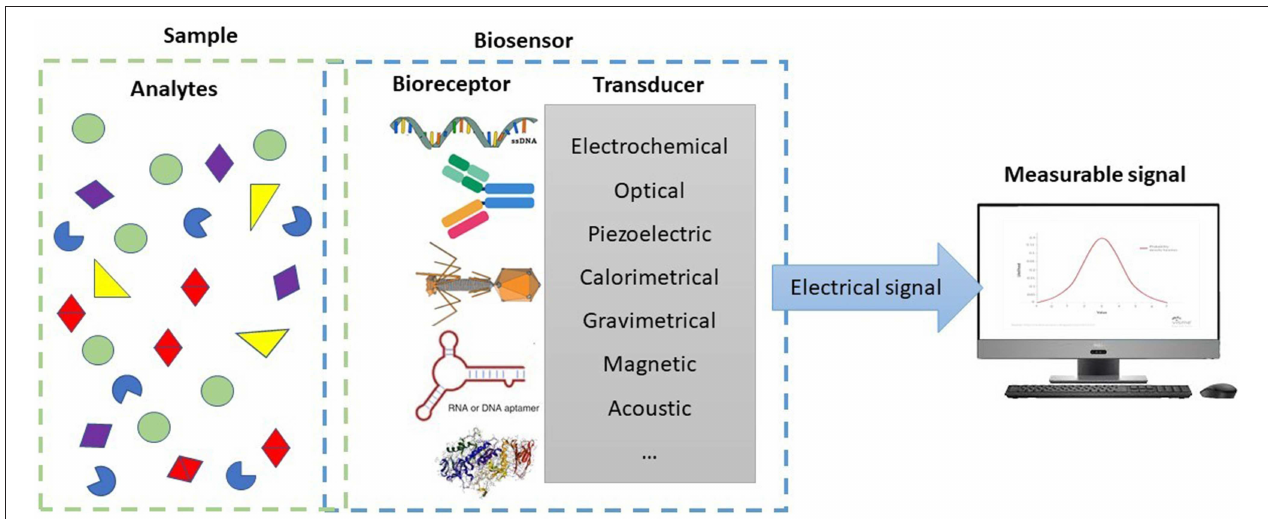
FIGURE 1 | Schematic representation of the elements of a